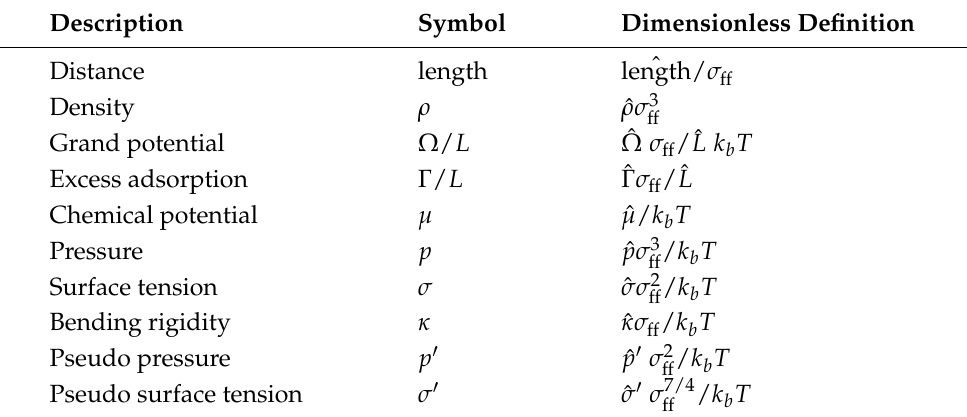
Table 2. An overview of the dimensionless variables used in the results section. “ ˆ ” denotes the dimensional equivalent of a dimensionless variable. In addition, k b is the Boltzmann constant, σ ff = 0.3575 nm, T = 77.3 K, and L is one dimensionless unit